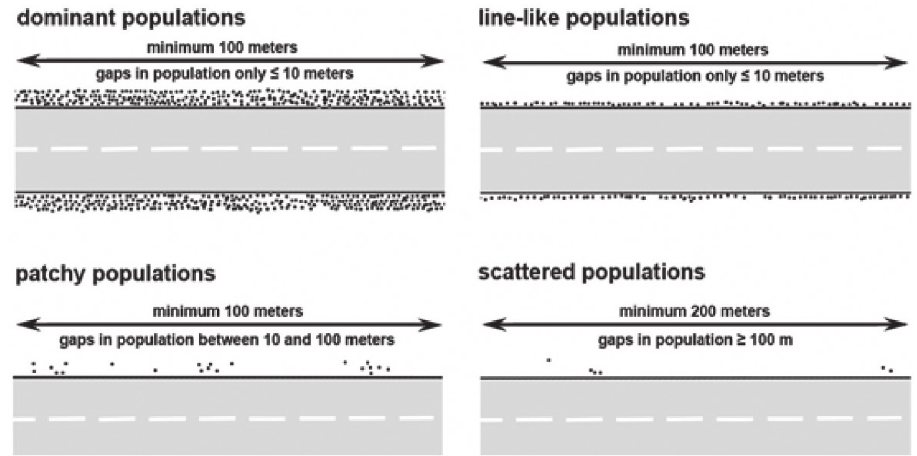
Figure 2. Visualization of the four population density classes of common ragweed mapped in the road net- work survey. Note that the minimum length for a change in recorded plant density during the mapping was different for ‘scattered populations’ (200 m) compared to the other three density classes (100 m). Dominant populations differed from line-like populations in their lateral expansion perpendicular to the